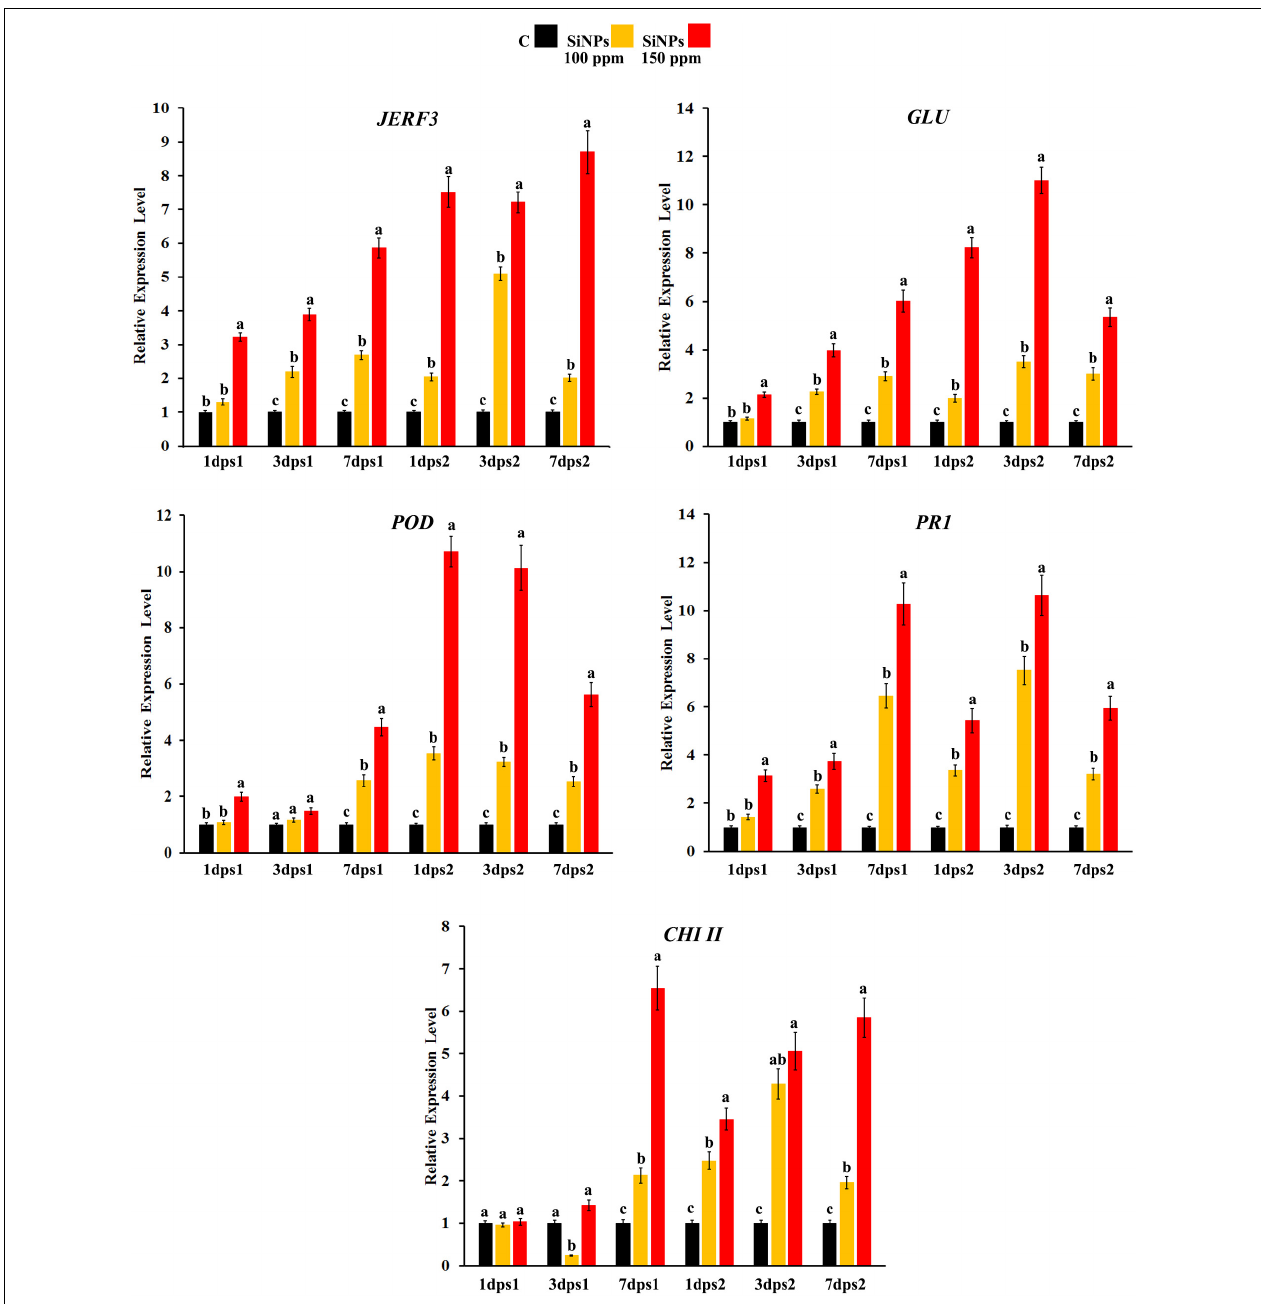
FIGURE 1 | Histograms showing the relative transcriptional expression levels of the transcription factor jasmonate and ethylene-responsive factor 3 ( JERF3 ) and four defense-related genes [ β -1,3-glucanase ( GLU ), peroxidase ( POD ), pathogenesis-related-protein 1 ( PR1 ), and chitinase class II ( CHI II )] in the leaves of grapevines infected with downy mildew in response to spraying of silica nanoparticles (SiNPs) at 100 and 150 ppm after 1, 3, and 7 days post the first spray (dps1), and days post the second spray (dps2). Where C: untreated-infected with downy mildew, SiNPs at 100: infected with downy mildew and treated with SiNPs at 100 ppm, and SiNPs at 150: infected with downy mildew and treated with SiNPs at 150 ppm. In each time for each studied gene, columns superscripted with the same letter are not significantly different according to Duncan’s multiple range test ( p ≤ 0.05). Each value represents the mean of three biological replicates; each sample was analyzed three times. Error bars represent